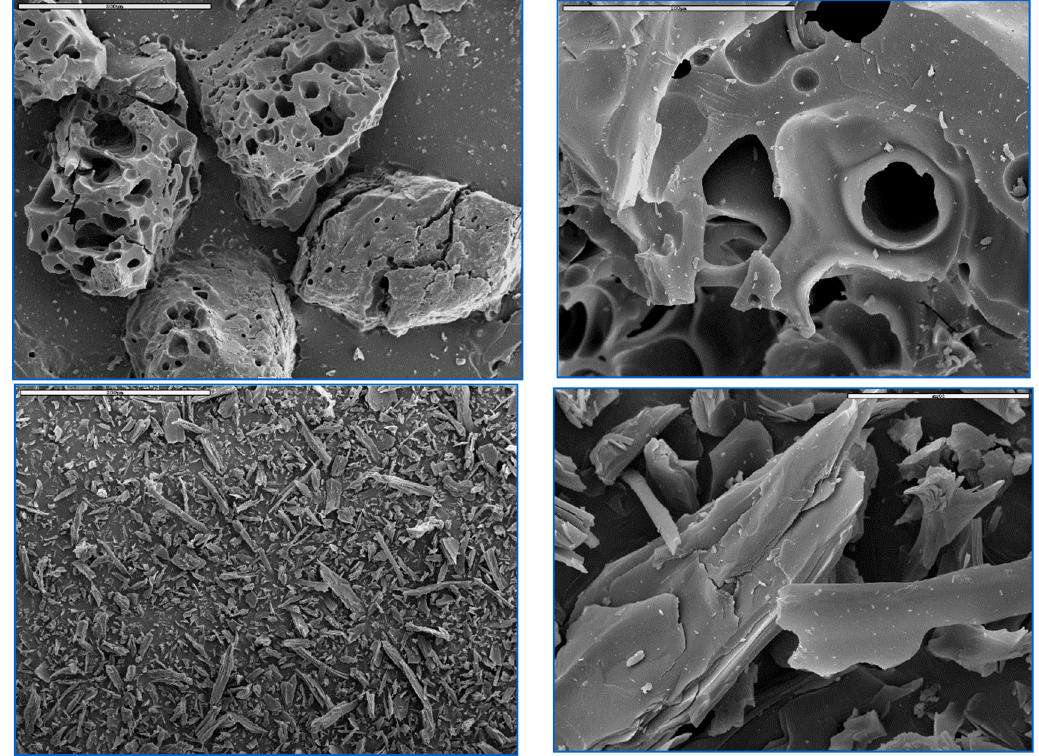
Figure 10. SEM images of ACs produced by KOH activation from bituminous coal (top) and pitch (bottom), pre-carbonized at 800 °C. Precursor/KOH ratio 1:3, reaction temperature 800 °C, soaking time 1 h.